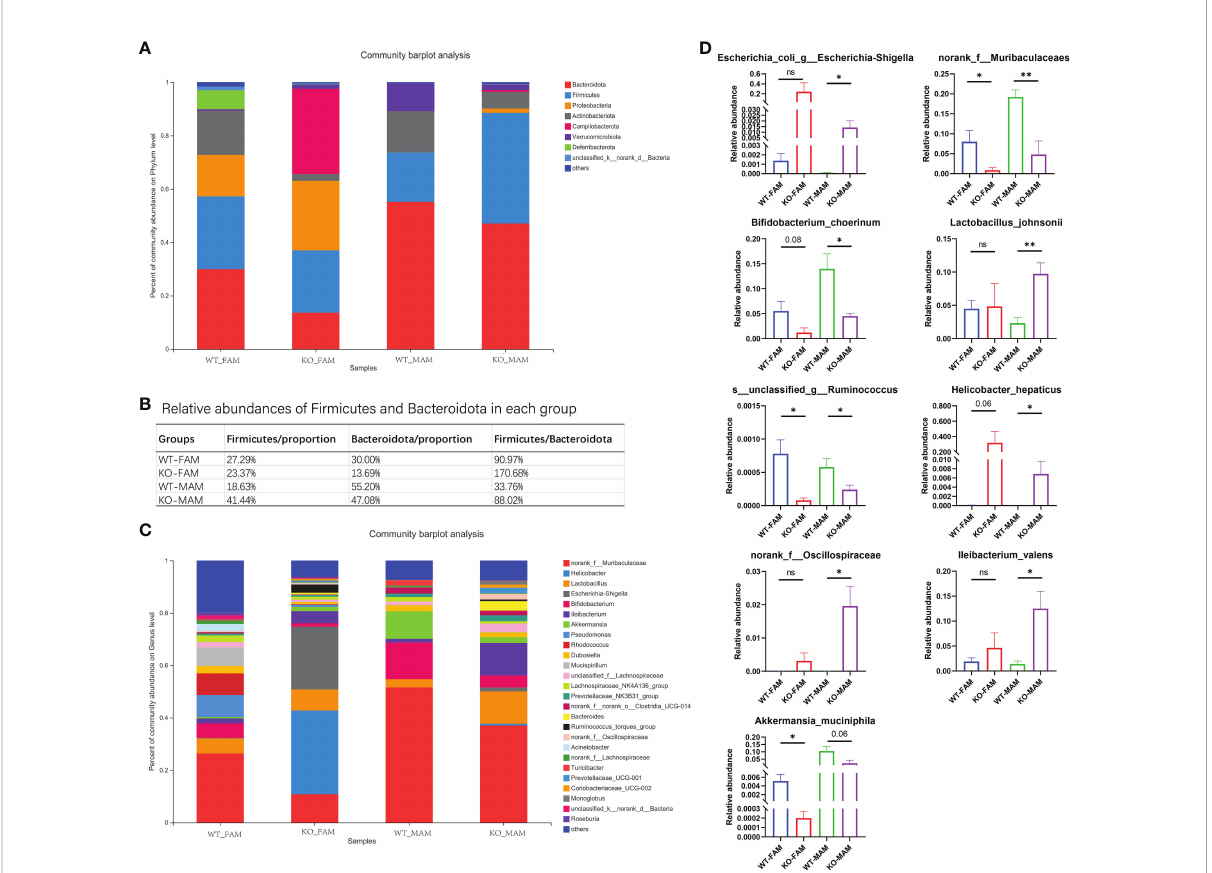
FIGURE 5 Bacterial composition of the different communities. Relative abundances of the gut microbiota at the phylum level (A) and genus level (C) ; (B) proportion of Firmicutes and Bacteroidia in each group. (D) Relative abundances of nine kinds of bacteria in each group. FAM, fecal- associated microbiota; MAM, mucosa-associated microbiota. *p < 0.05, **p < 0.01, ns, no signi fi